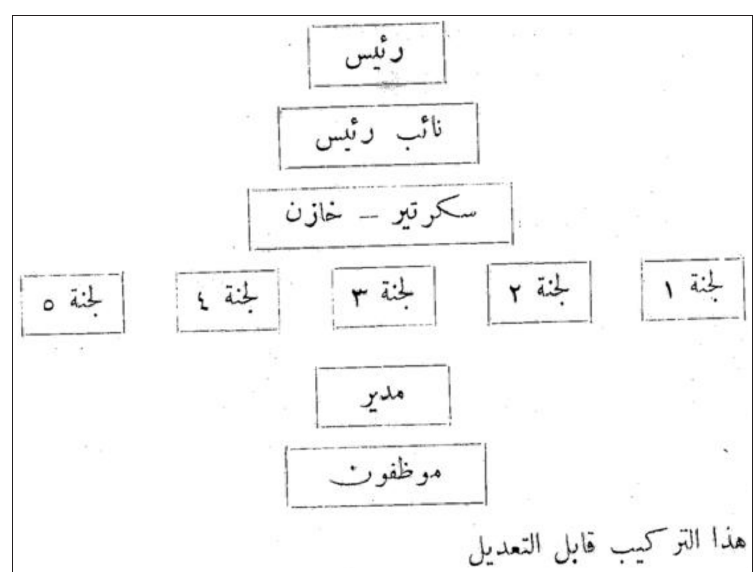
Figure 22: Example of table format.